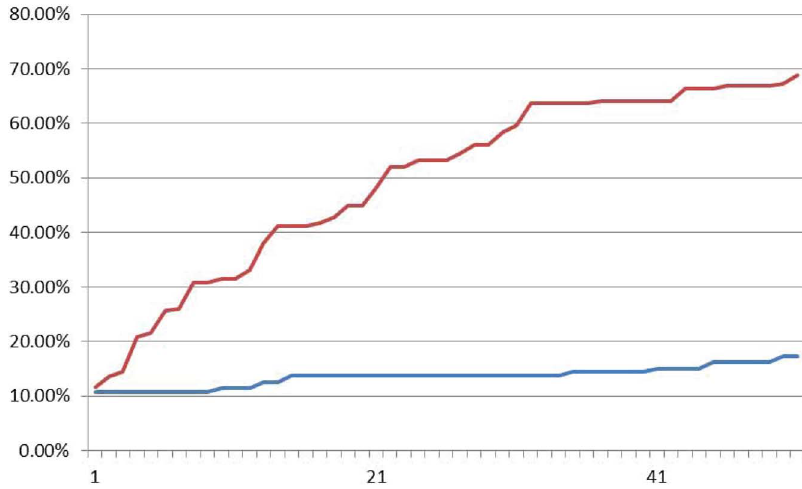
Figure 15. Fluoroscence data of DNA Neurons execute AND logic with input ‘‘11’’. The X-axis is cycling time of Real-time PCR, the time span of each cycle is 10 minutes, temperature of each cycle keeps in 24–25 u C. The Y-axis is relative intensity of HEX (red curve) and FAM (blue curve).